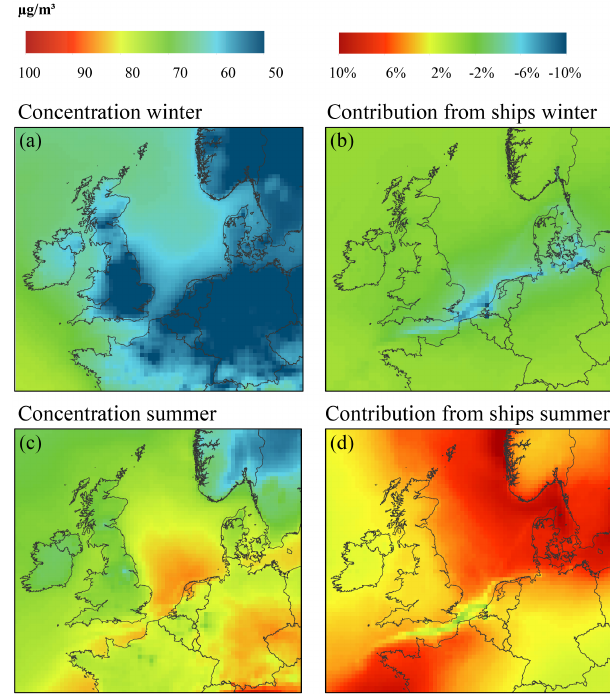
Figure 14. O 3 in summer and winter and the relative contribution of ship